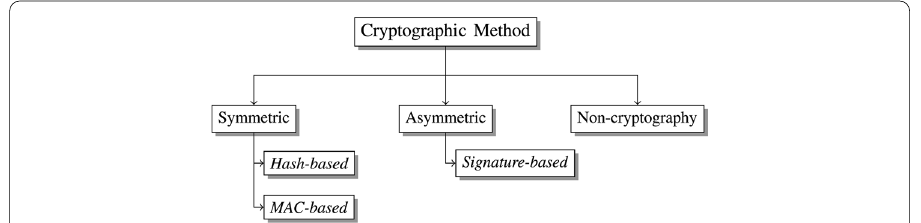
Fig. 11 Cryptographic method class in expanded